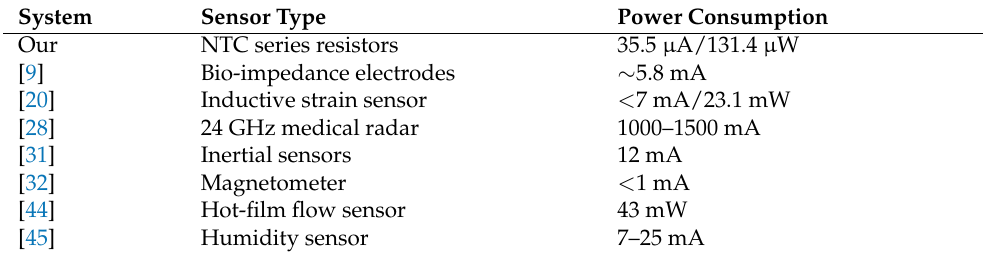
Table 2. Power consumption compared to other